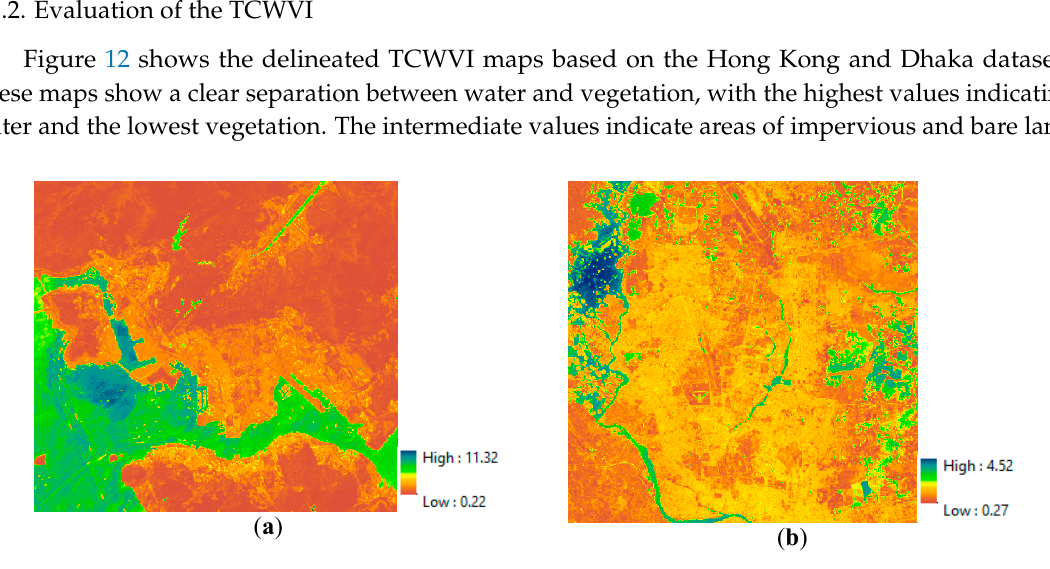
Table 5. Sensitivity of indices in the detection of vegetation and water.